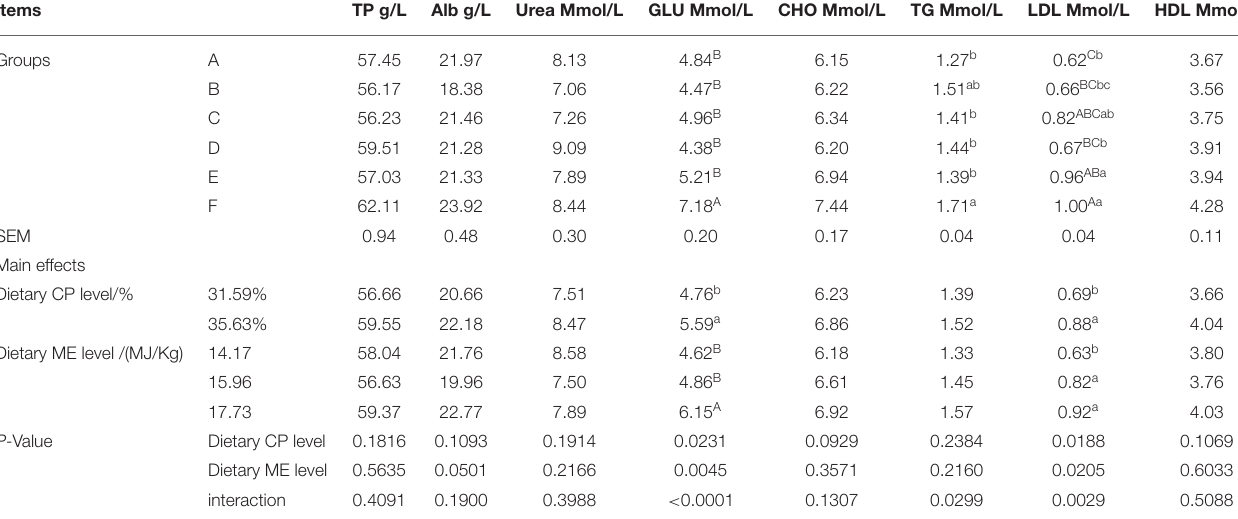
TABLE 7 | Effects of energy and protein levels on Serum biochemical parameters of minks during growing season.